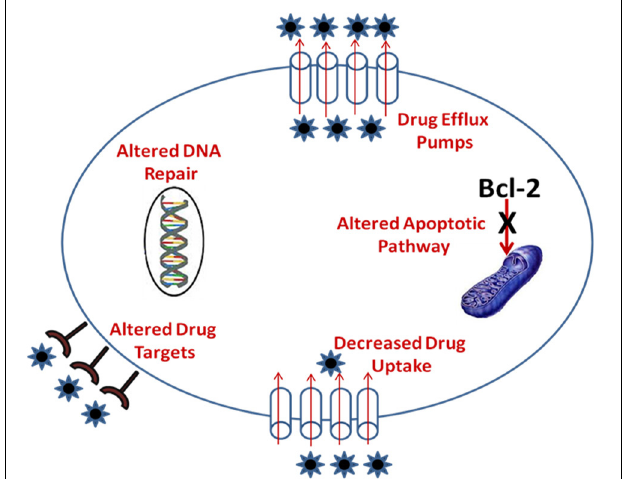
FIGURE 1 | Mechanism of multidrug resistance in tumor cell.